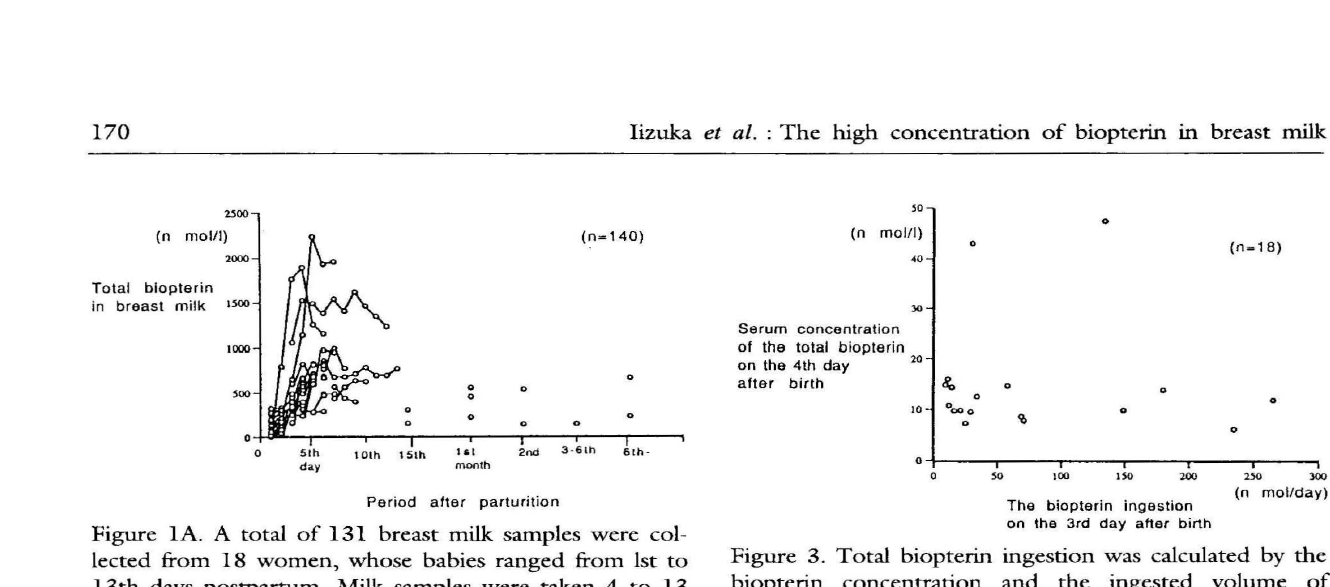
Figure 3. Total biopterin ingestion was calculated by the biopterin concentration and the ingested volume of breast milk on the 3rd day. Eighteen serum samples were collected on the 4th day. Analysis of the total biopterin in milk and serum was carried out as described in the text.